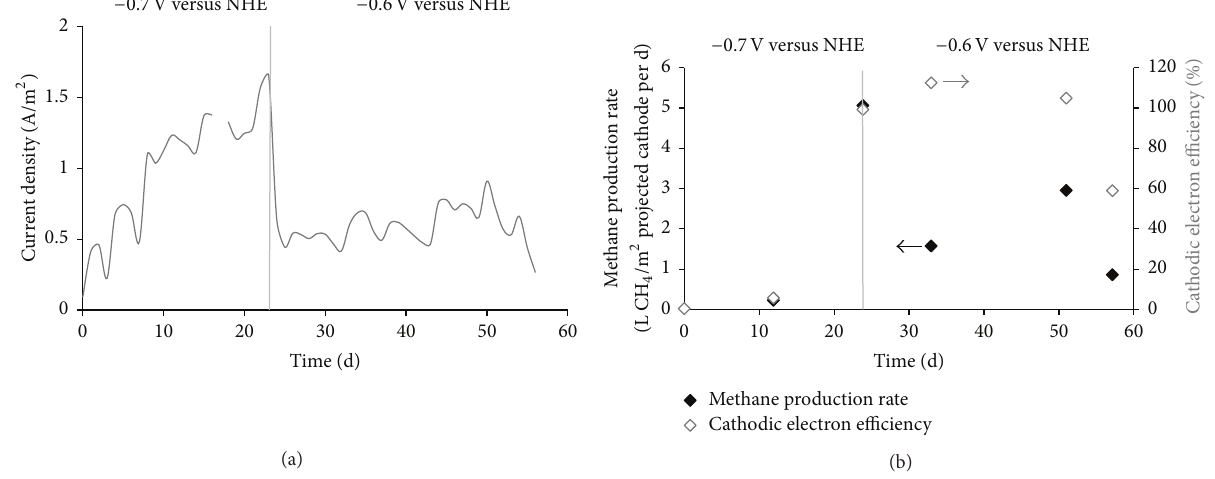
Figure 2: (a)Current density (daily averages) and (b) methane production rate and cathodic electron efficiency with time. Cathode potential was changed from − 0.7 V versus NHE to − 0.6 V versus NHE (day 24), as indicated by the grey vertical line. changed from − 0.7 V to − 0.6 V versus NHE. After changing with a daily average of 0.60 ± 0.16 A/m 2 projected